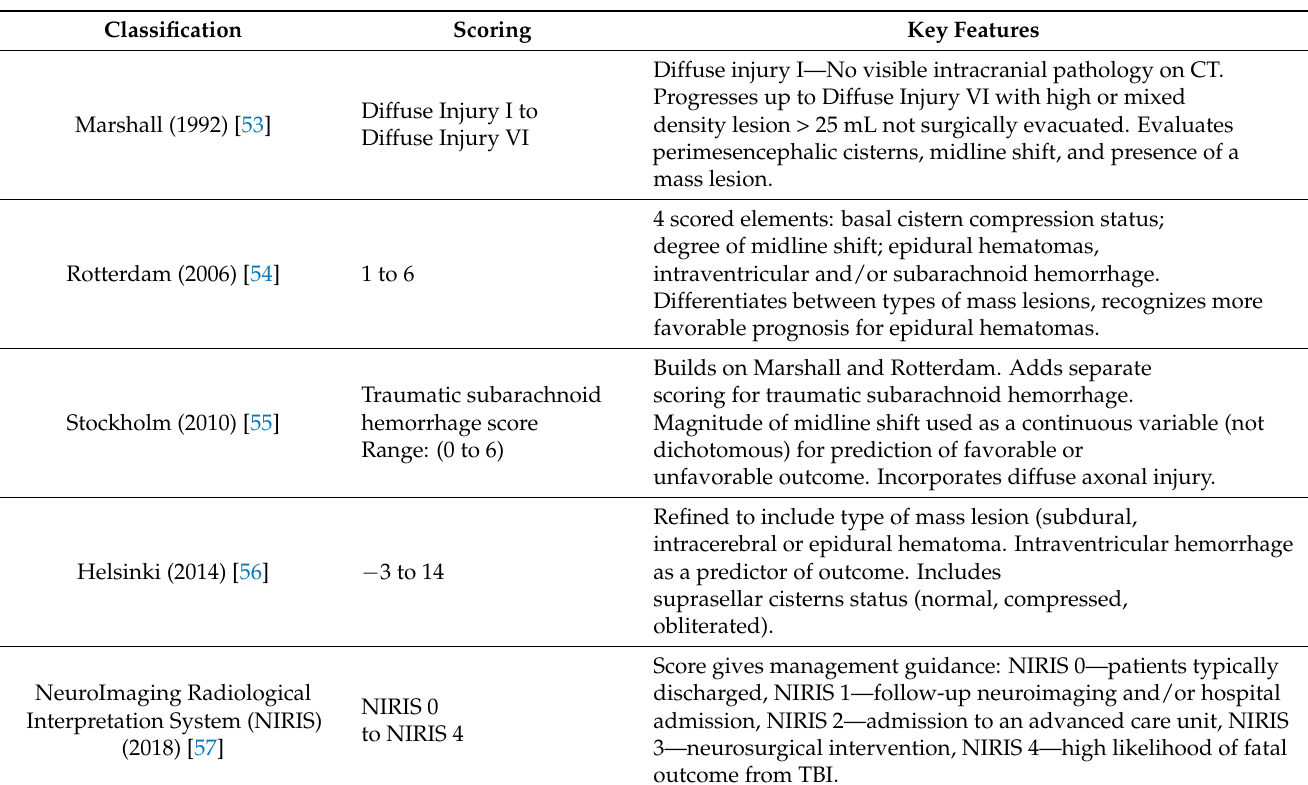
Table 1. Summary of classifications systems based on imaging for risk stratification and prediction of mortality in